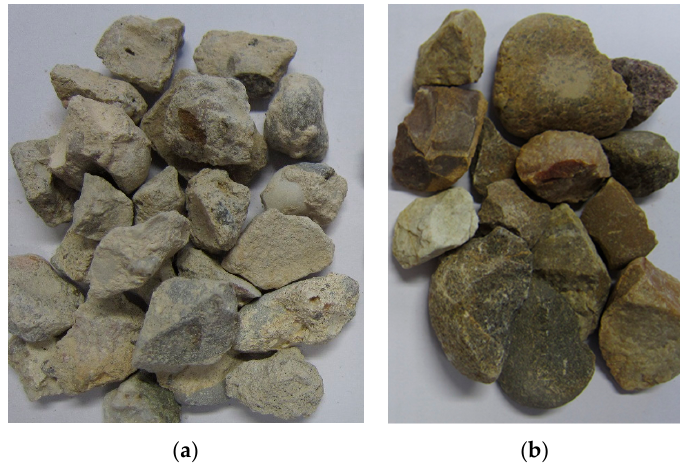
Figure 2. Coarse aggregate utilized: ( a ) derived from concrete waste; and ( b ) natural aggregate.